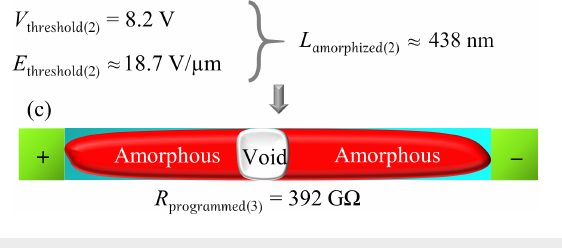
Figure 5: Schematic illustration of the calculation of the amorphized length for two post-reset re-amorphization episodes shown in Figure 4: (a) after initial reset, (b) after first re-amorphization at V threshold(1) of 1.9 V, (c) after a second re-amorphization and physical breaking with loss of electrical connection at V threshold(2) of 8.2 V. Threshold voltage values indicate the voltage at which the already existing amorphous region experienced electrical breakdown during threshold